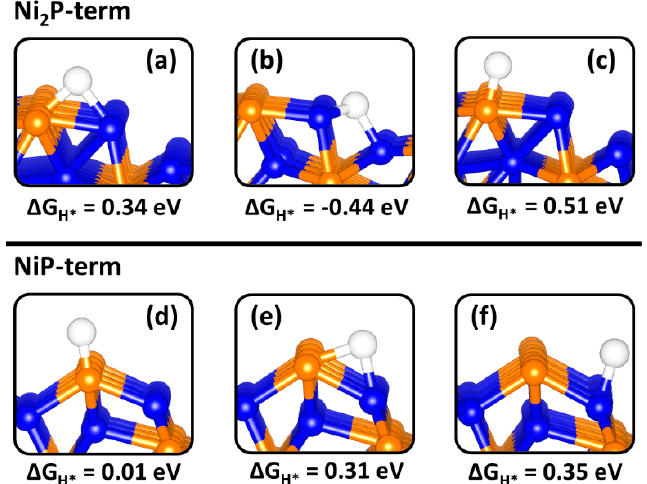
Figure 8. Gibbs free of hydrogen adsorption ( ∆ G H* ) at di ff erent binding sites on the (1010) surface of Ni 2 P. Whereby ( a – c ) show a Ni-P-bridge, Ni-Ni-bridge and P-top respectively on the (1010)-Ni 2 P termination and ( d – f ) are the P-top, Ni-P-bridge and Ni-top respectively on the (1010)-NiP termination.